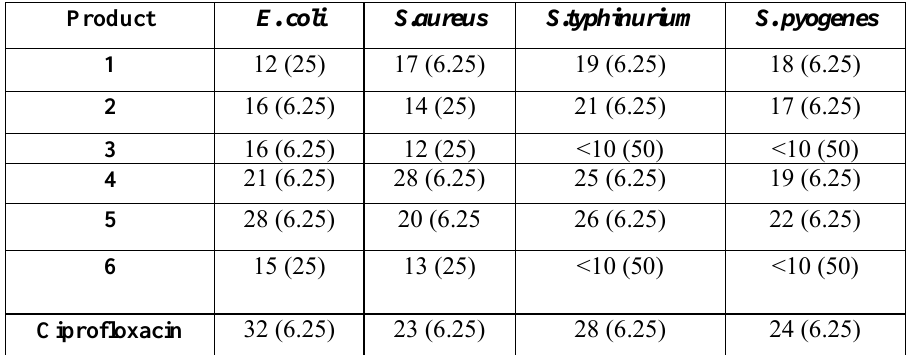
Table 2. Antibacterial activities of the compounds 1-6.